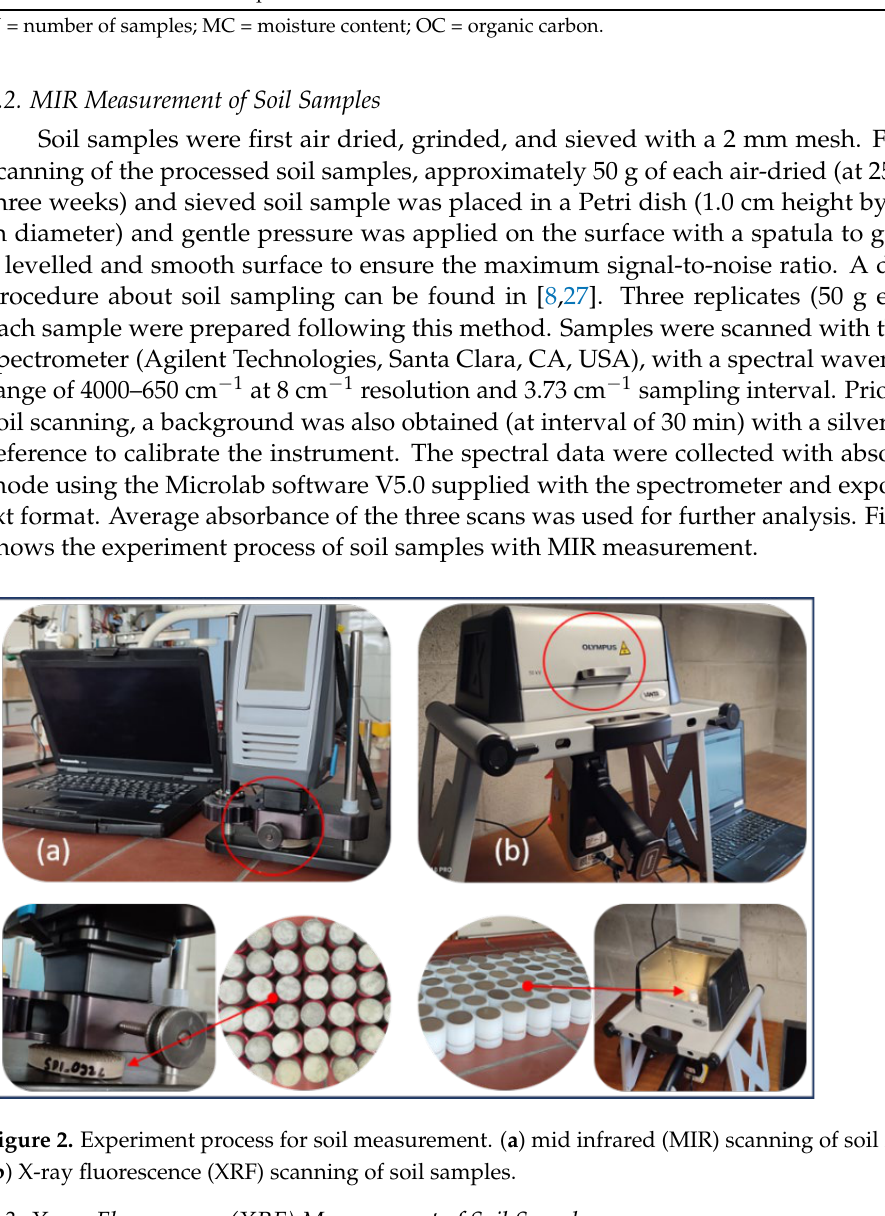
urement window and scanned in triplicate in two operating conditions (15 kV at 30 µA; and 45 kV at 30 µA) by moving the sample cups over the measurement window of the scanner.